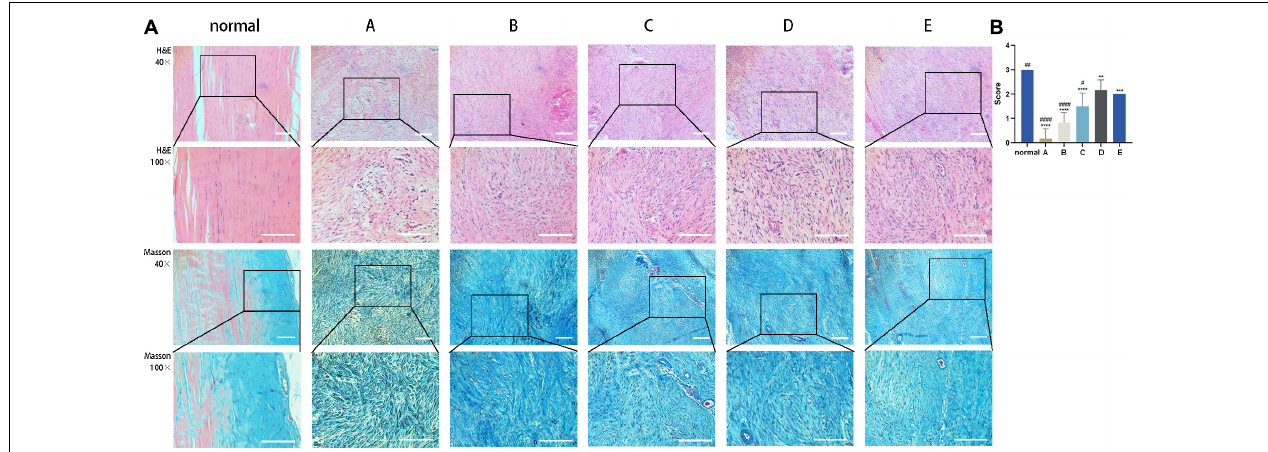
FIGURE 6 | CM promotes the orderly arrangement of tendon fibers. (A) Sections of healed tendon tissue stained with H&E and Masson’s trichrome were observed by light microscopy at 40 × and 100 × magnification. Achilles tendon tissue sections treated with CM5 and CM6 (i.e., Group D and Group E) showed a much more regular and compact alignment of collagen fibers compared to the other groups. (B) Histogram of fiber alignment score. With the increase of HGF concentration, tendon fibers arranged orderly. Bars: 500 µ m. ∗ , versus normal. ∗∗ means p < 0.01, ∗∗∗ means p < 0.001, ∗∗∗∗ means p < 0.0001. #, versus D. # means p < 0.05, ## means p < 0.01, #### means p <